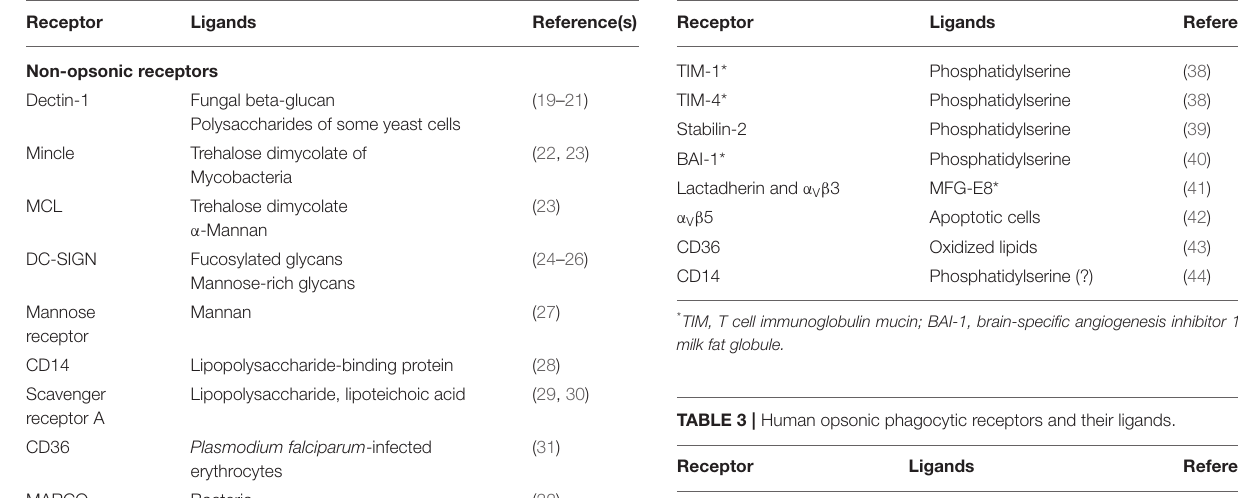
TABLE 1 | Human non-opsonic phagocytic receptors and their ligands. TABLE 2 | Receptors for apoptotic cells.